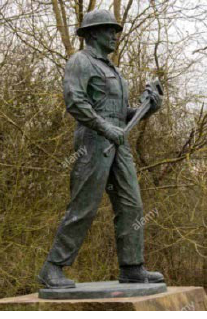
Fig. 15, A plane model above the German Museum of Technology,